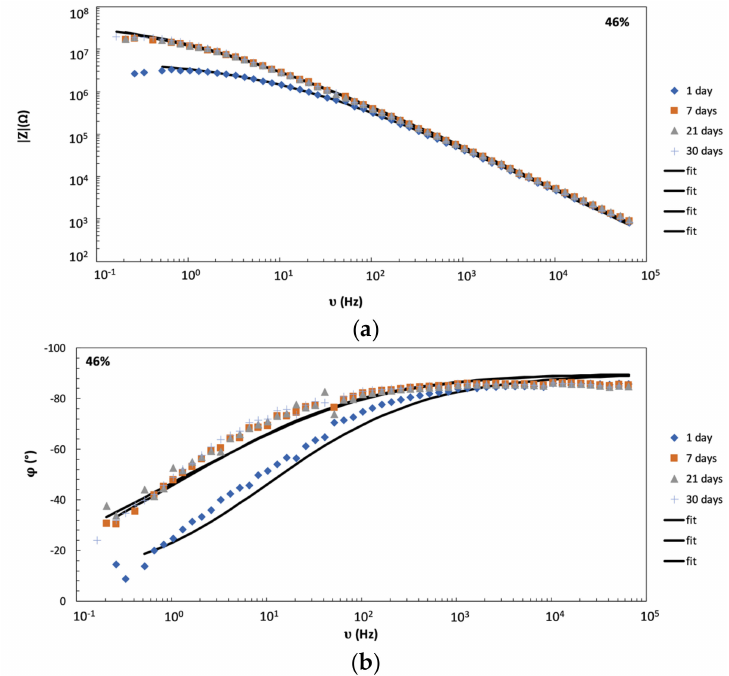
Figure 5. Impedance spectra of representative samples WB-talc coatings series with di ff erent PVC in the Bode diagrams: ( a ) Modulus and ( b ) phase angle vs. log